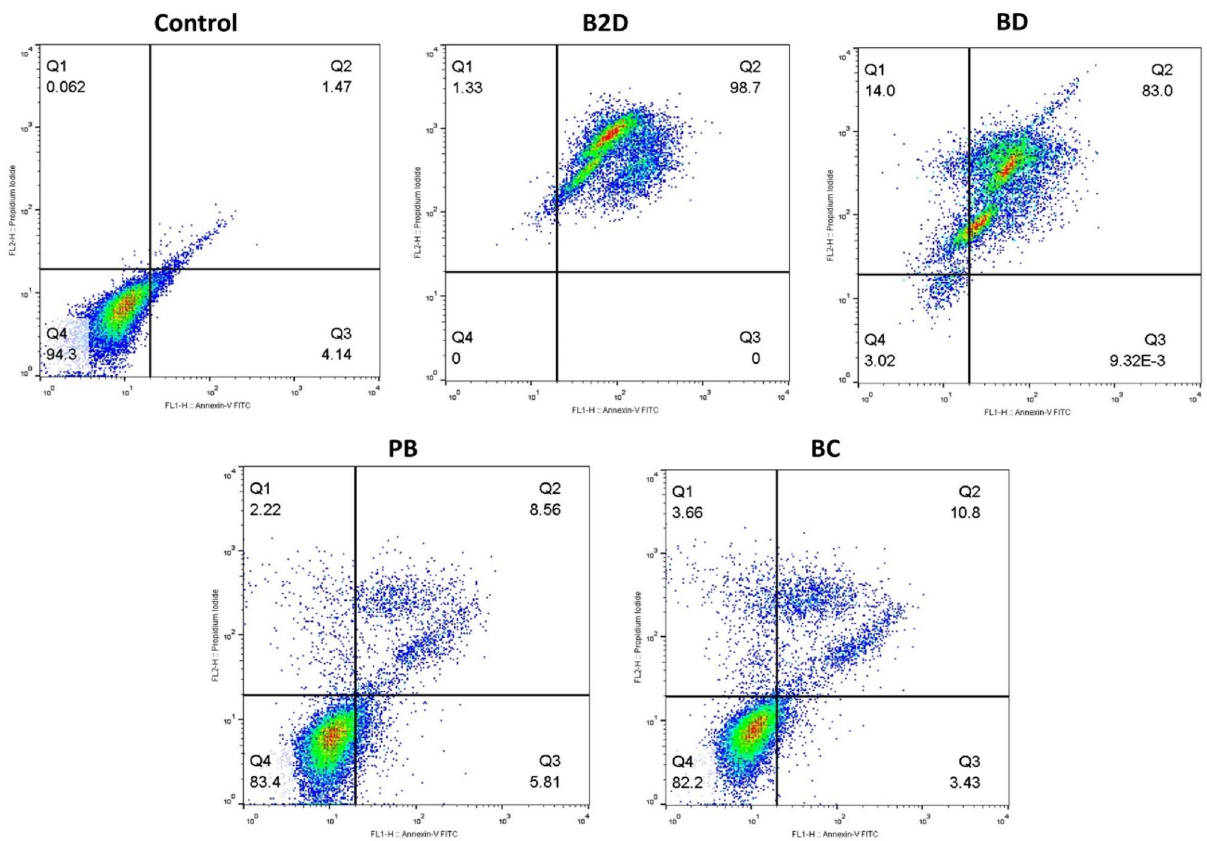
Figure 7. Enhanced antitumor effecacy by increased apoptotic cell death induced by co-delivery of Dox and Conf nano-formulation. Results of apoptosis test of MDA-MB-231 cells treated by nano formulations (0.259 μg/ mL of B2D , BD , BC and 2.59 μg/mL of PB ) obtained by flowcytometry method. (Abbreviations: PB : blank βCD-g-PMA-co-PLGA micelles, B2D : co-drug loaded βCD-g-PMA-co-PLGA micelles, BD : Dox loaded βCD- g-PMA-co-PLGA micelles, BC : Conferone loaded βCD-g-PMA-co-PLGA